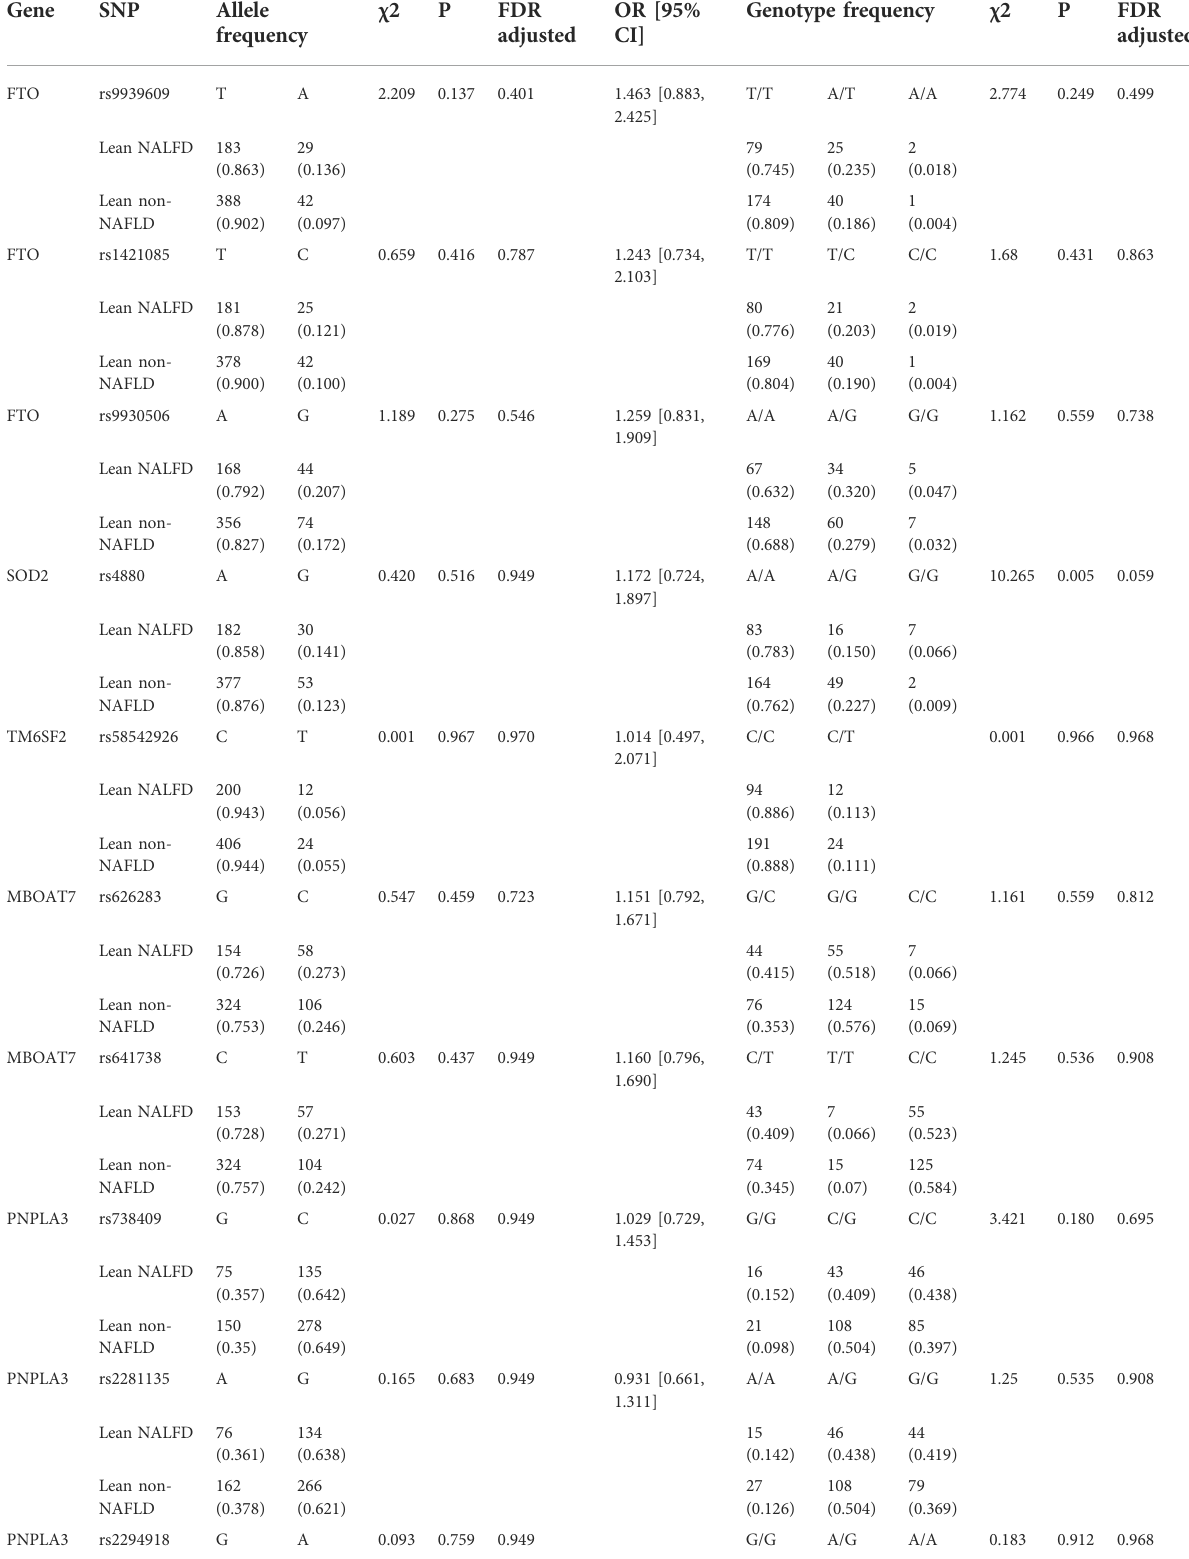
TABLE 3 Analyzed genes allele and genotype distribution in lean